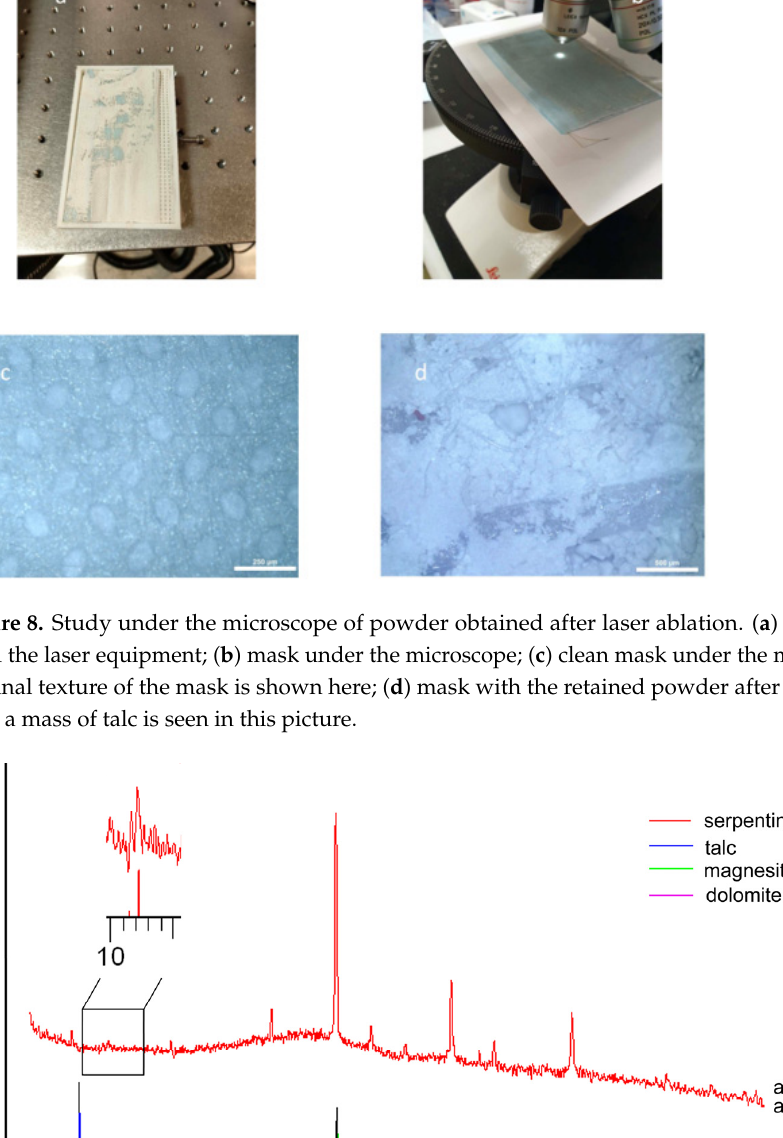
Figure 9. Diffractogram of sample M-17 before (raw) and after laser ablation; the black square in the figure indicates the enlarged diffractogram area underneath, where the main reflection of the serpentine mineral phase is clearly